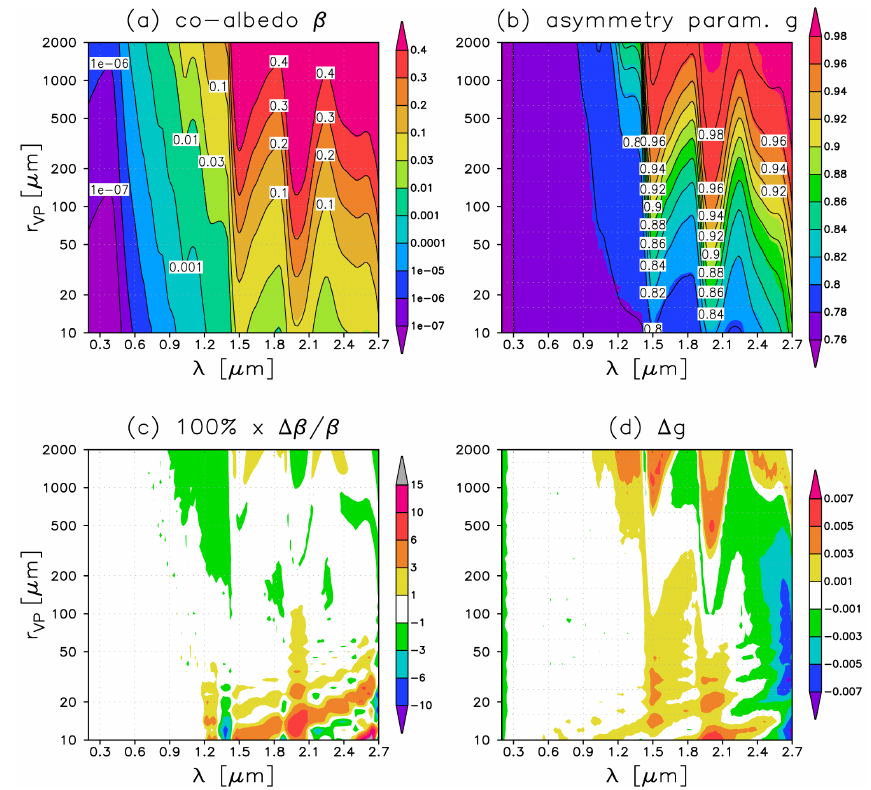
Figure 8. Comparison of (a) parameterized single-scattering co-albedo β (contours) with the reference values computed for the OHC (shad- ing) and (b) parameterized asymmetry parameter g (contours) with the reference values (shading). (c) Relative errors (%) in the parameterized co-albedo. (d) Absolute errors in the parameterized asymmetry